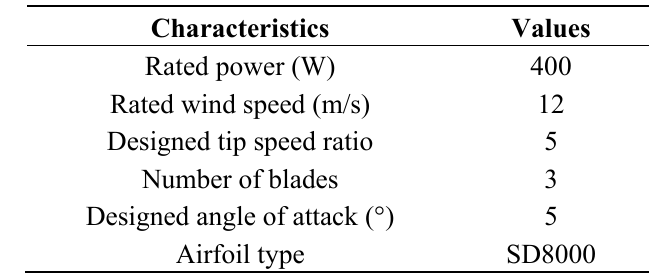
Table 1. The blade design parameters.